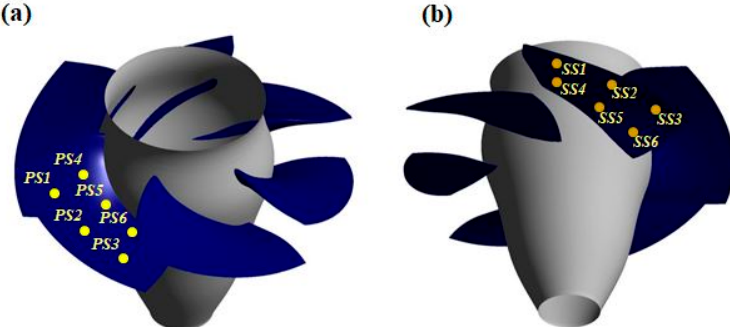
Figure 1. Pressure sensors location on two consecutive runner blades. ( a ) PS1 to PS6 on the pressure ( b ) SS1 to SS6 on the suction side. ( b ) SS1 to SS6 on the suction side.